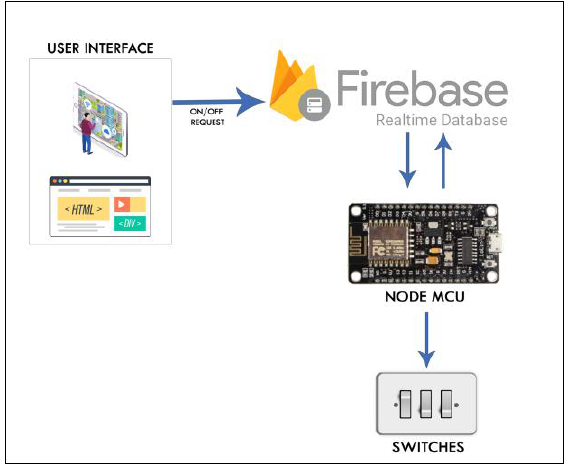
Figure 3. Architecture for Electric Switching using Real-time Database